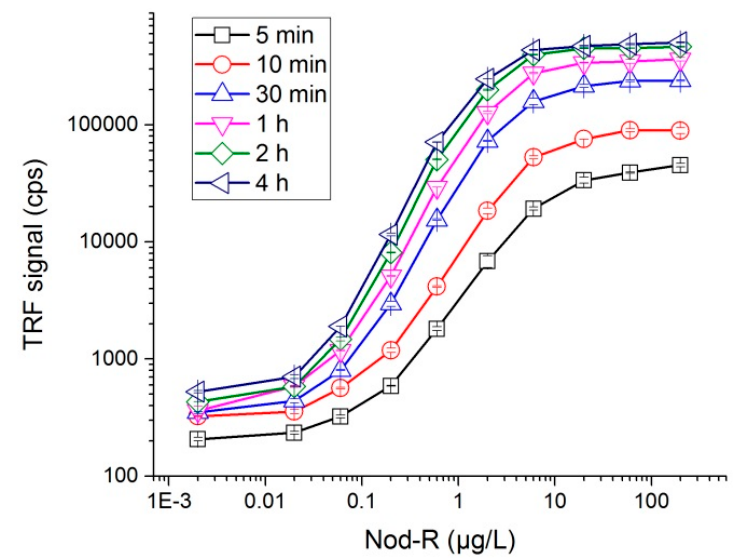
Figure 2. The dose-response curves for the single-step non-competitive assay with different reaction times. Each data point represents the average of duplicate measurements and the standard errors of the means are shown with error bars. TRF: Time-resolved fluorescence. Cps: counts per second.